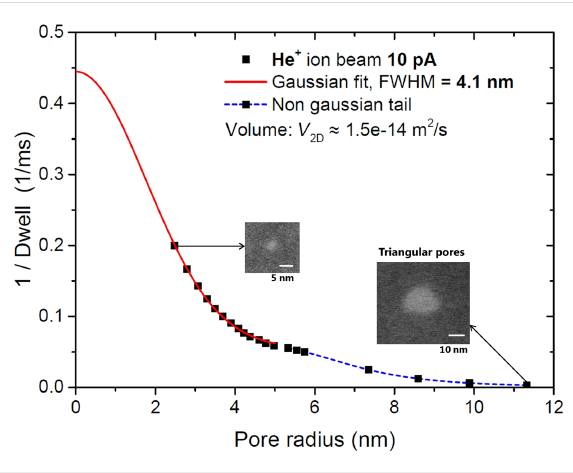
Figure 3: 10 pA Helium ion beam profile extracted from graphene perforation experiments. The main peak can be fitted well with a Gaussian shape. Insets are STEM images of the pores made by main part of the ion beam and its tail. Note a triangular pore shape created by long